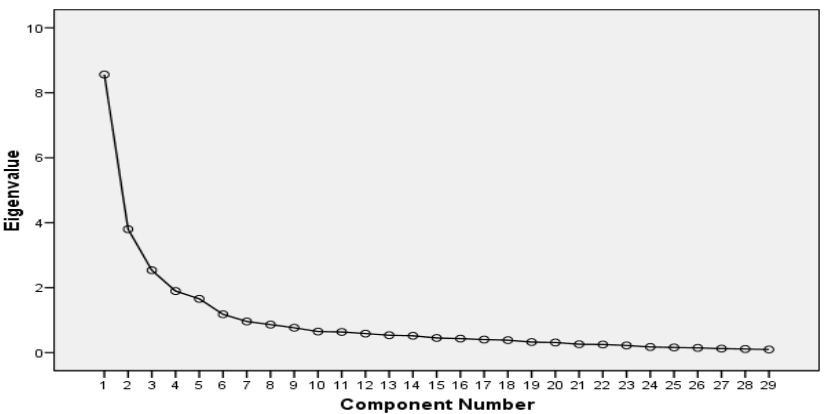
Figure 5. Scree plot.